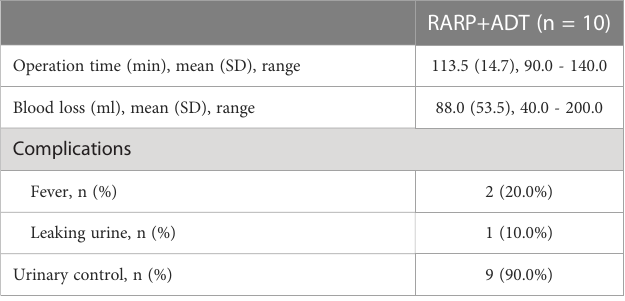
TABLE 2 Perioperative data of RARP+ADT